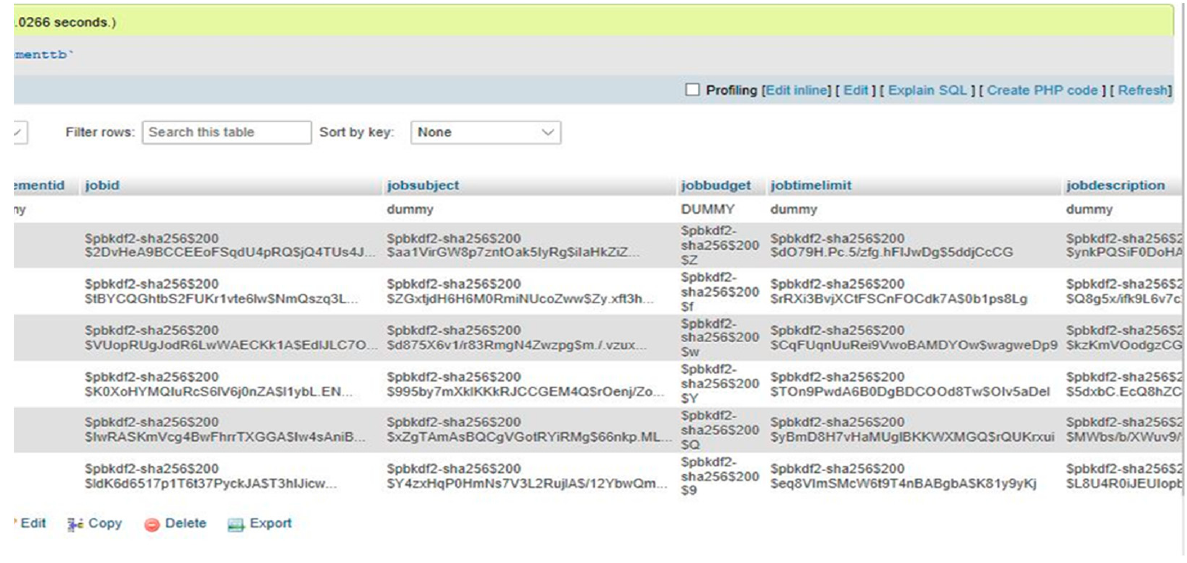
Figure 19. Storage of job details mentioned on the smart contract form in a hashed format.